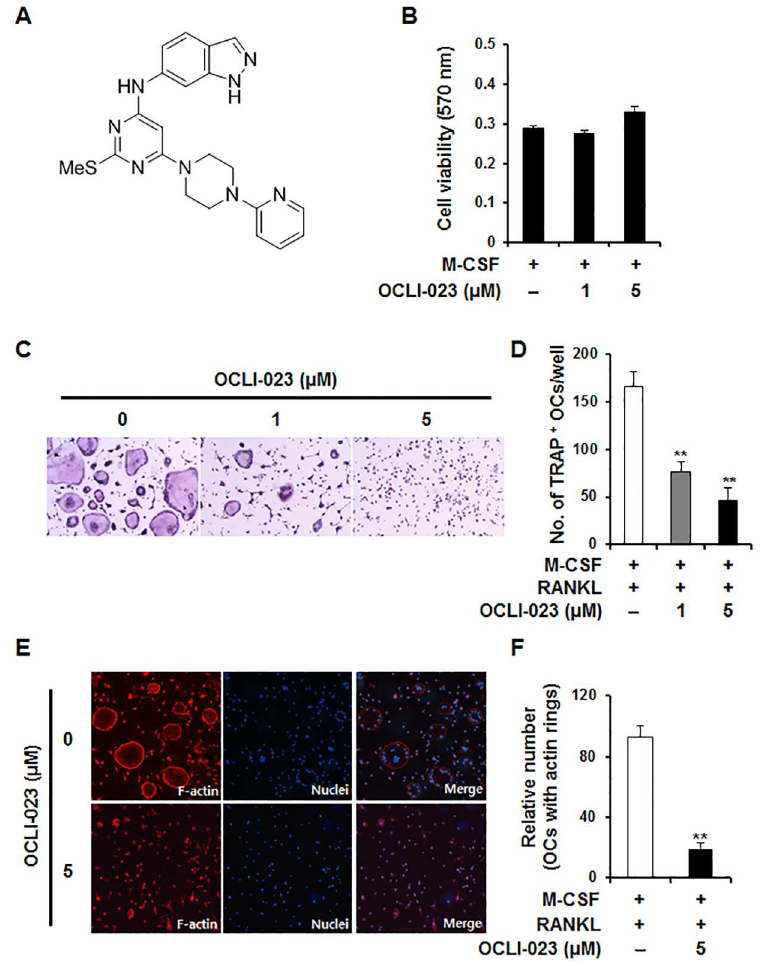
Fig 1. Effects of OCLI-023 on osteoclast differentiation in RANKL-stimulated BMMs. (A) Chemical structure of OCLI-023. (B) BMMs were incubatedfor 3 days with M-CSF (10 ng/mL) in the presence or absenceof 1 μ M or 5 μ M OCLI-023. Cell viabilitywas evaluatedby the MTT assay. (C) BMMs were cultured with M-CSF (10 ng/mL) and RANKL (20 ng/mL) either with or without 1 μ M or 5 μ M OCLI-023. After 4 or 5 days, the cells were fixed and stainedwith TRAP. Magnification; 50X. (D) TRAP-positive multinucleated cells with (cid:21) 3 nucleiwere scored. ** p < 0.01 versus the vehicle-treated control. (E) BMMs were cultured on glass coverslipsfor 4 days with M-CSF (10 ng/mL) and RANKL (20 ng/mL) in the presenceor absenceof OCLI-023 (5 μ M). The cells were stainedwith rhodamine-conjugated phalloidinand DAPI to visualizeactin rings and nuclei,respectively.(F) The numberof actin rings was analyzed. ** p < 0.01 versus the vehicle-treated control.